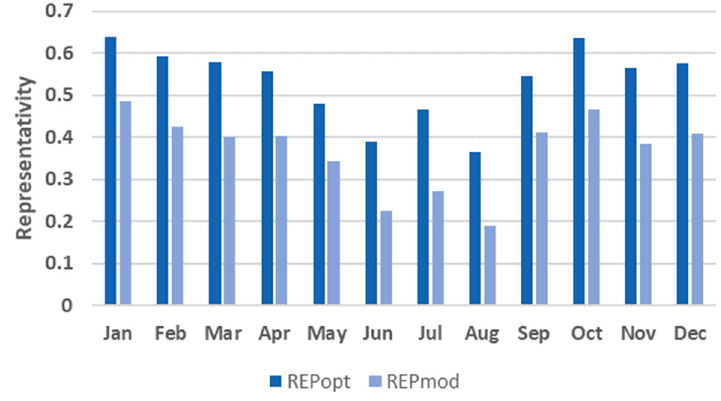
Figure 6. Mean monthly representativity values for monthly mean precipitation. REPopt denotes the interpolation with optimum parameters and REPmod represents interpolation with modelled parameters.